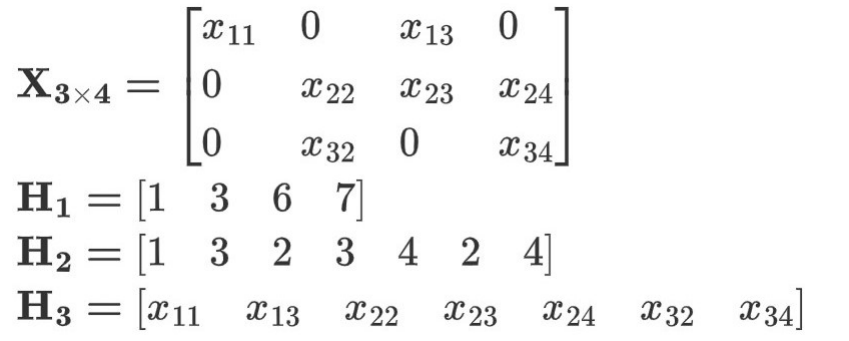
Figure 3. Data matrix